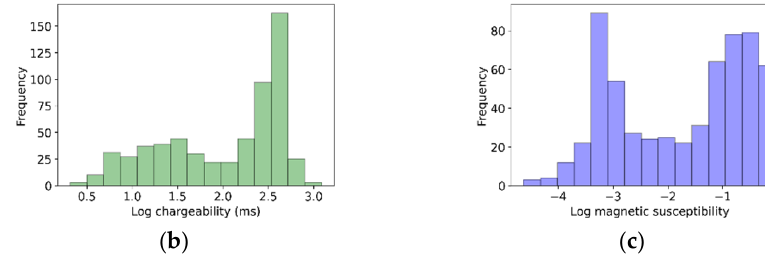
Figure 3. Histograms of log value of ( a ) electrical resistivity, ( b ) chargeability, and ( c ) magnetic susceptibility of rock samples.